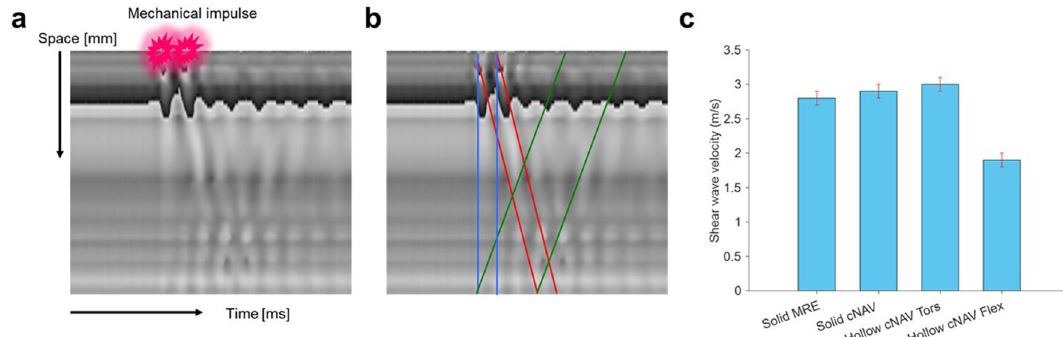
Figure 6. Validation of cNAV method in a phantom material. (a) Example of a time-distance waterfall plot obtained in a large solid cylinder showing the phase of the pencil beam acquisition. Two mechanical impulses (red stars) provoke the propagation of different wave modes travelling through the sampled volume over time. ( b) In blue, propagation of the compressional (longitudinal) wave. Due to its high speed (1550 m/s) this is practically a vertical line. In red, propagation of the shear wave. In green, reflected shear waves and shear waves originating from mode conversion. ( c) Shear wave velocity values obtained with classical MRE in a large block of plastisol (left) serving as the reference standard, and results obtained with the pencil beam method for different phantom geometries (solid, hollow) and different wave modes (torsional,